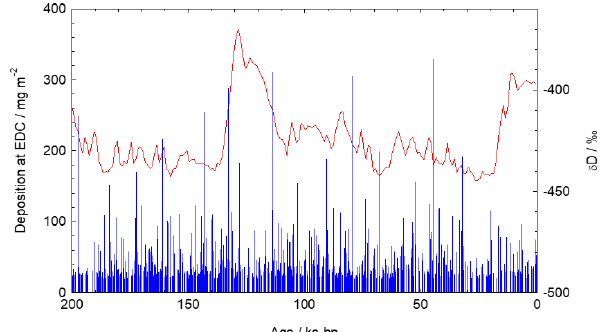
Figure 5. The deposition flux of sulfate for events with deposition more than 20mgm − 2 over the last 200kyr (blue, left axis). Antarc- tic δ D is shown in red (right axis) to indicate the climatic